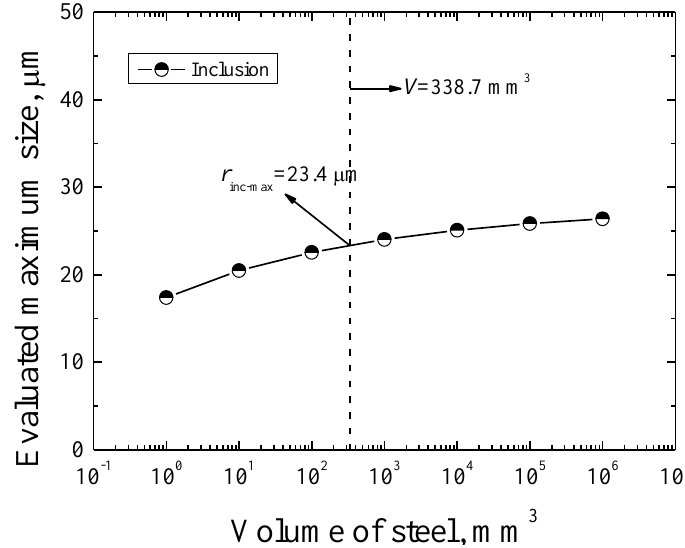
Figure 13. Relationships between defect size and control volume of alloy steel ( V ) .